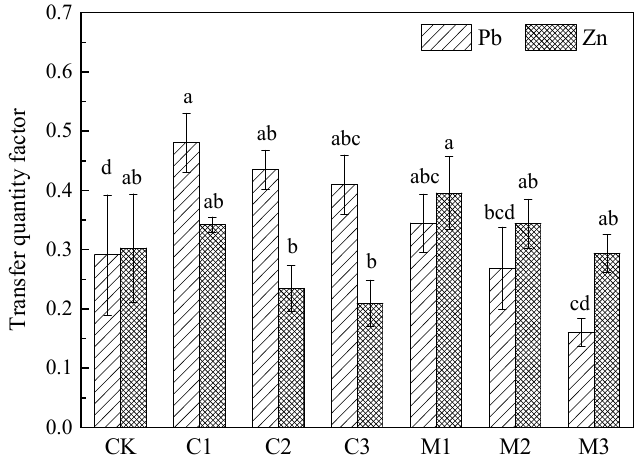
Figure 7. Transfer factor of Nerium indicum under calcium carbonate and mushroom residue im- proved treatment.